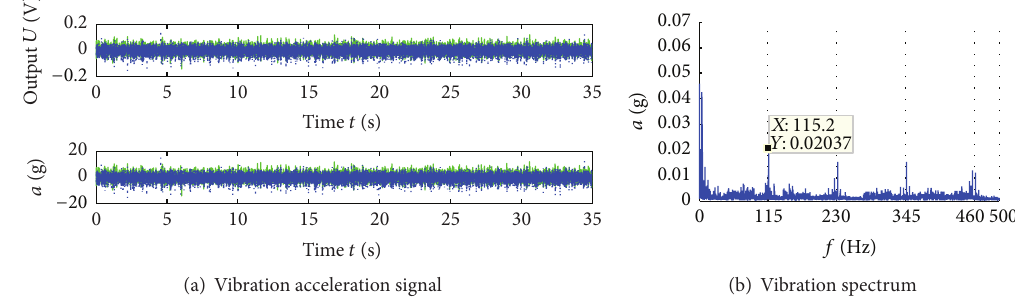
Figure 6: Vibration signal detection of gearbox with modification gear.